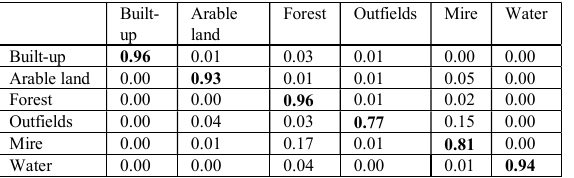
Table 3. The normalized confusion matrix for the RF algorithm